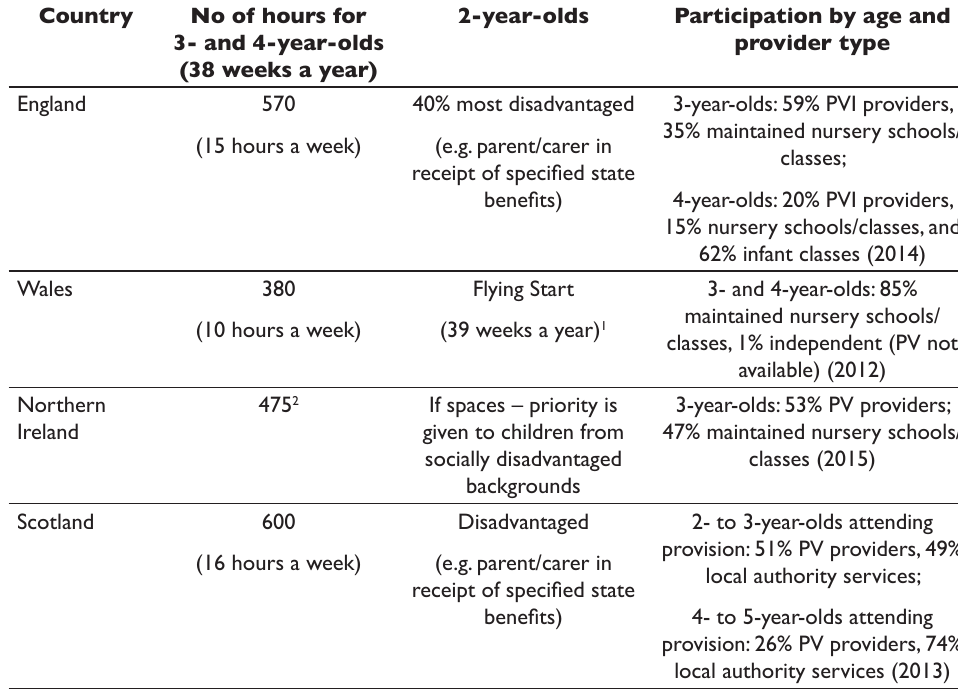
Table 1: Free part-time early education (2015)